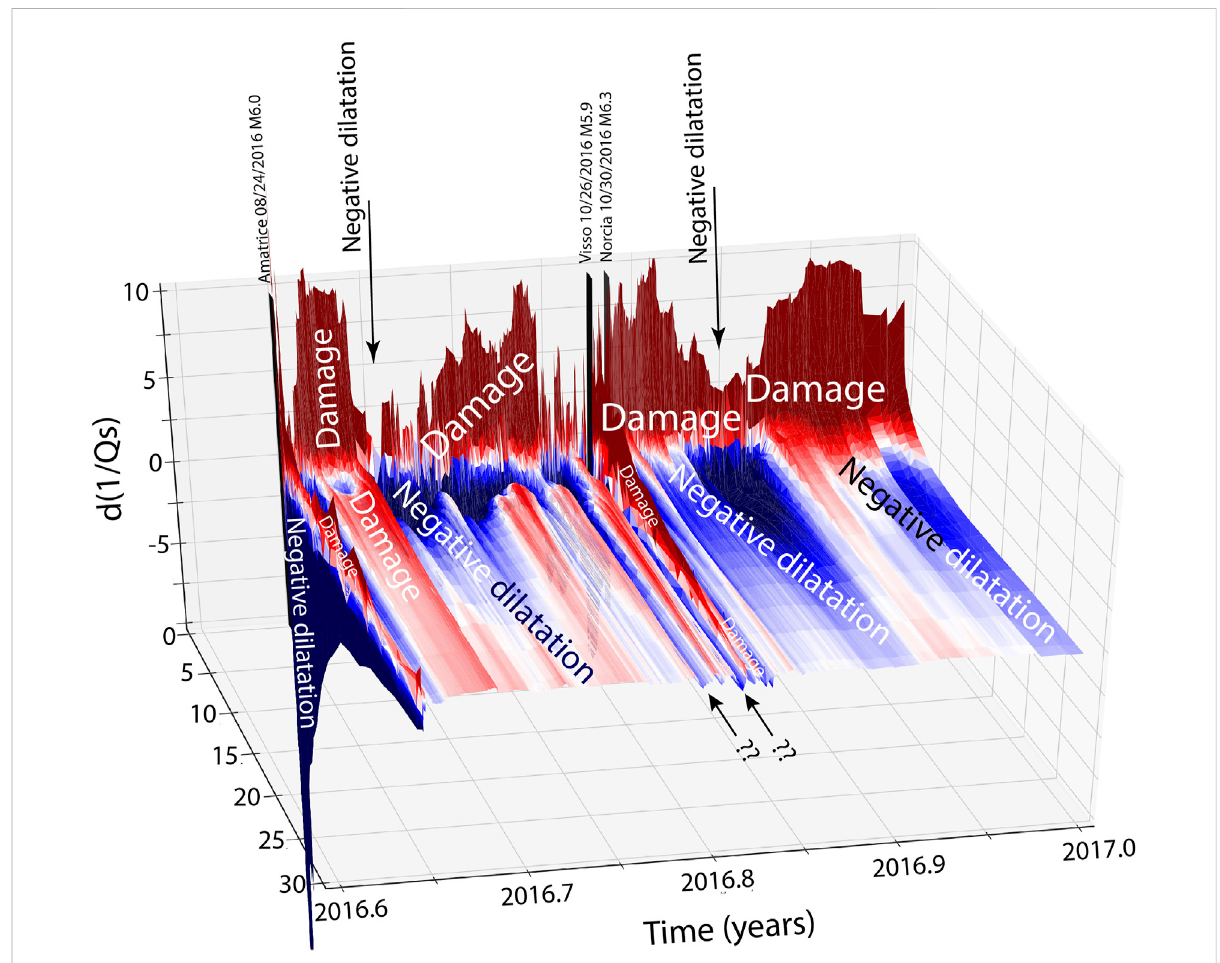
FIGURE 13 Zoom on the 3D visualization of the seismic attenuation parameter Q − 1 S ( f , t ) (from Figure 5C), during the most energetic part of the Amatrice- Visso-Norcia seismic sequence. It is very clear that the main events produce a sharp coseismic drop in seismic attenuation at relatively high frequencies (only frequencies f ≥ 1 Hz are plotted here) due to crack closing (Muir-Wood and King, 1993), followed by a more gentle rise, probably due to fl uid displacement through diffusion, and a wide trough that is probably due to the cumulative effects of coseismic crack closure produced by the aftershocks. The pattern is reproduced after each main event. Patterns of colors relative to “ damage ” and “ negative dilatation ” are